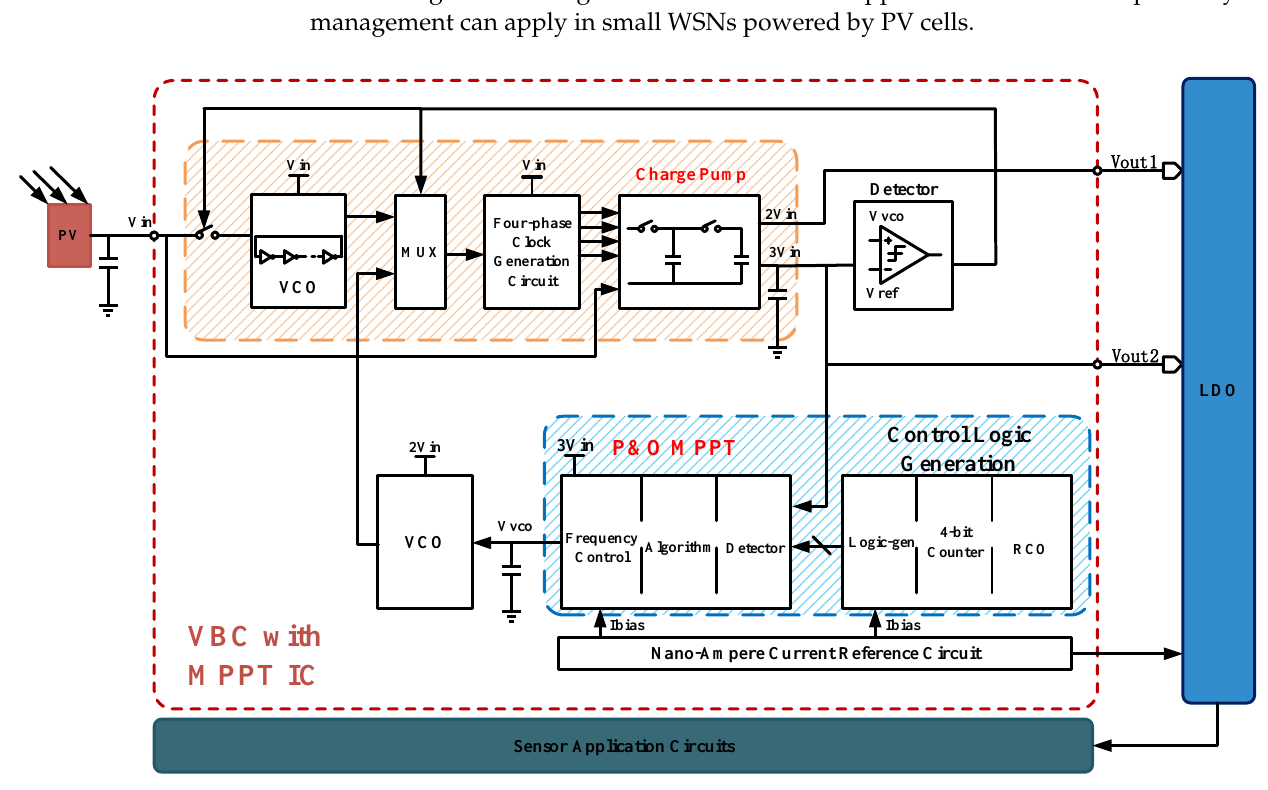
Figure 5. Block diagram of VBC with MPPT.